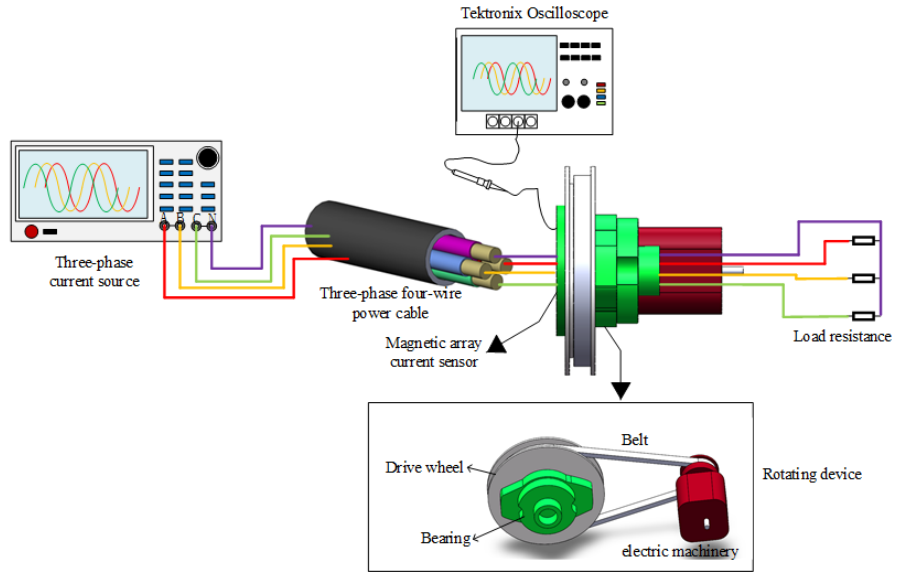
Figure 12. Three-phase four-wire cable phase current measurement experimental system.